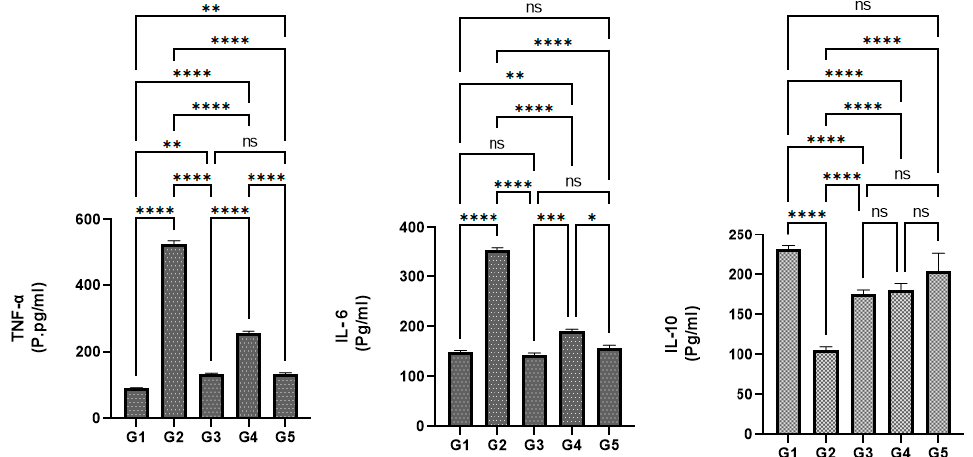
Figure 9. Influences of the PDE on TNF a, IL 6, and IL10 levels in the serum specimens of the ethanol-induced gastric ulcerogenic rats. G1, normal control; G2, ulcer control; G3, reference rats (omeprazole, 20 mg/kg); G4, rats received 200 mg/kg of the PDE; G5, rats received 400 mg/kg of the PDE. Data are expressed as means ± SEM ( n = 6). The significant levels are presented as *, p < 0.05; **, p < 0.01; ***, p < 0.001; **** , p < 0.0001 .